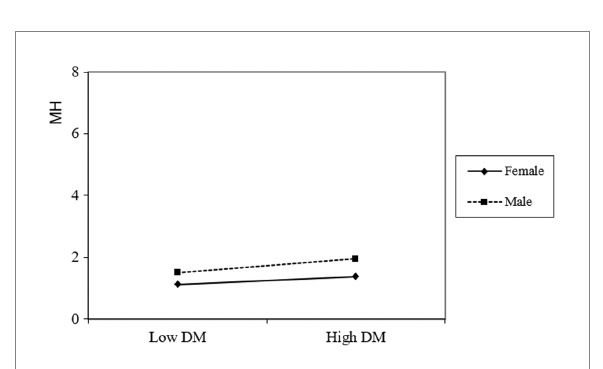
FIGURE 3 The moderating effect of gender in the relationship between dispositional mindfulness and mental